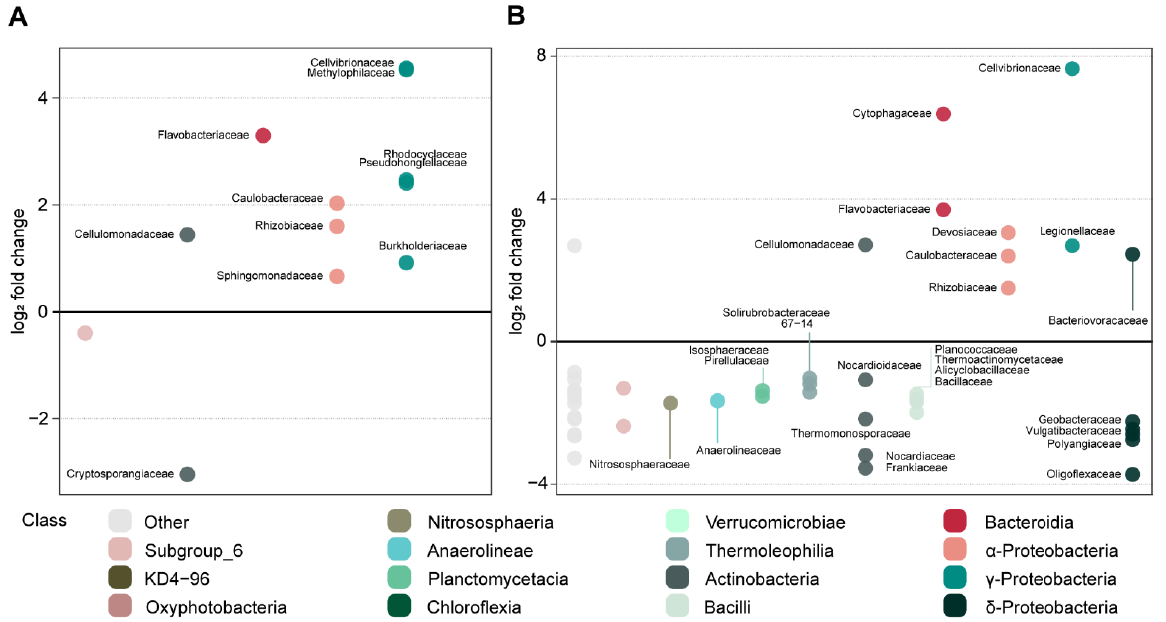
Figure 9. Effect of oak ( A ) and paper pulp ( B ) amendment as compared to control on bacterial families in soil sampled 7 days after amendment. Bacterial families significantly over- (log 2 fold change > 0) and under-represented (log 2 fold change < 0) were highlighted by differential abundance analyses (Wald test p < 0.01). Bacterial/fungal families are grouped by class along the x -axis; classes with relative abundance < 3% are indicated as “Other”.